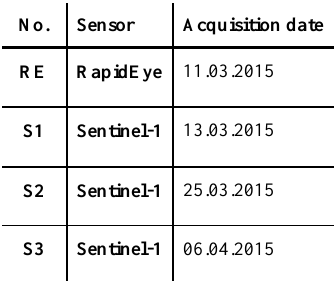
Table 1. Remote Sensing data obtained for this study RapidEye data was radiometrically calibrated to radiance and atmospheric correction was applied using the FLAASH module in ENVI. Orthorectification was performed with the RPC- Orthorectification workflow in ENVI. The image was resampled to 15m spatial resolution and projected to WGS84, UTM Zone